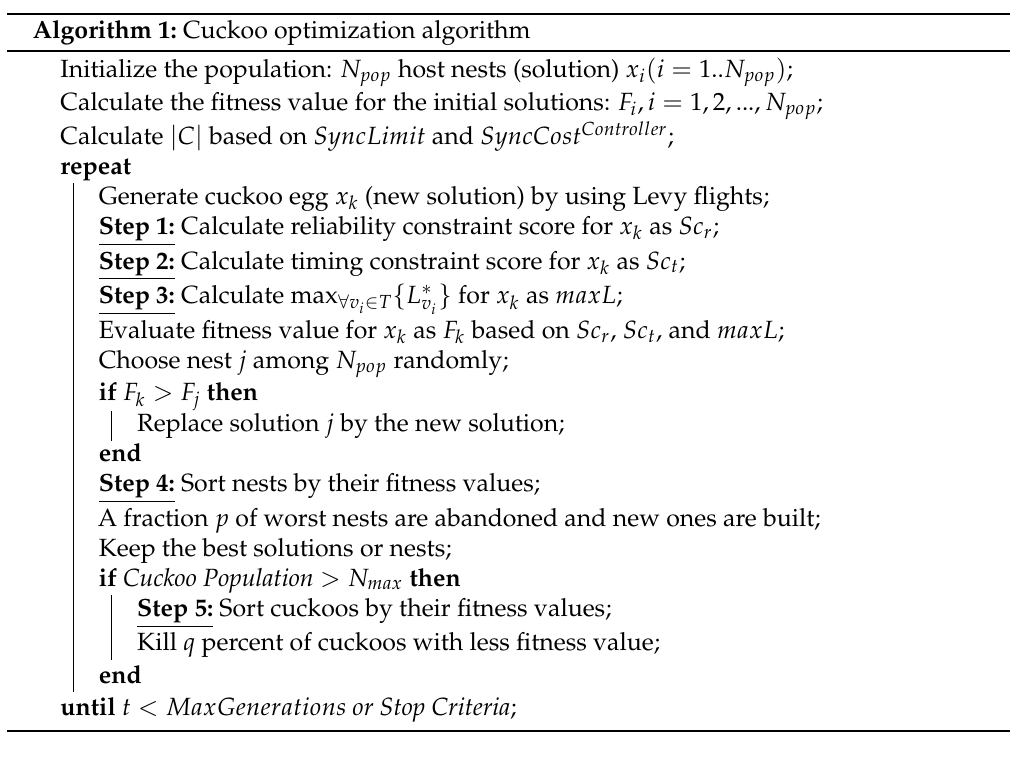
Algorithm 1: Cuckoo optimization